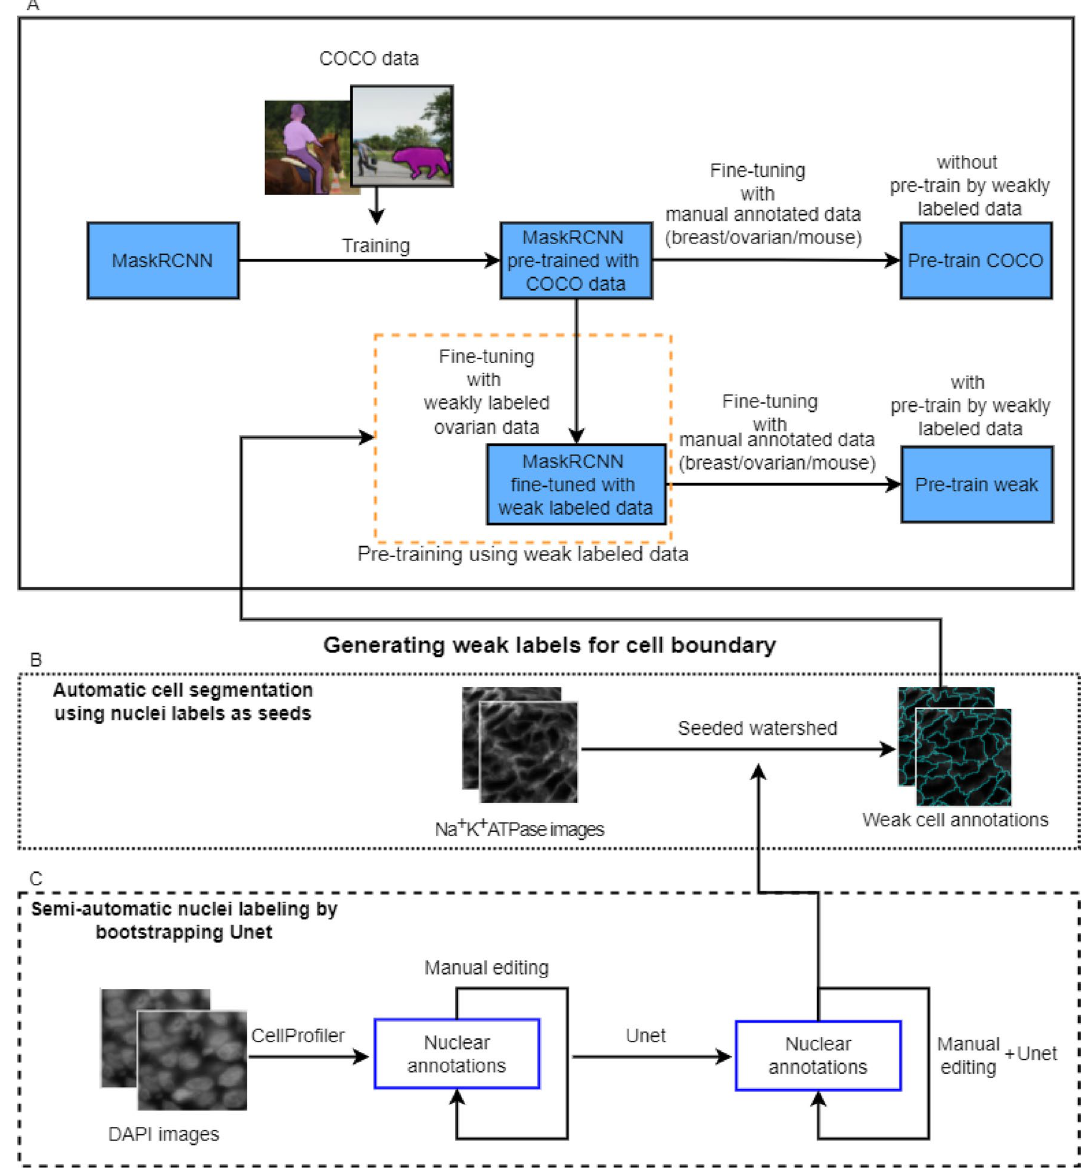
Figure 1. Workflow diagram for methodology: ( A ) (within black solid box) demonstrates the methods of training a Mask R-CNN model using domain adaptation with and without pre-training using weakly labeled ovarian data. The corresponding final models are referred to as pre-train weak and pre-train COCO respectively. The dotted and dashed boxes (i.e. B and C ) demonstrate the process of generating weak annotations for the cell boundaries: ( B ) describes using the Na + K + ATPase image to generate weak (i.e. rough estimation) annotations for cell boundaries using seeded watershed by using nuclear labels as seeds. ( C ) demonstrates the semi- automatic nuclear segmentation using bootstrapped U-net after CellProfiler labeling and manual editing of the nuclear annotations. This figure is created using diagrams.net (https:// www. diagr ams. switch between the DAPI channel, MEM channel, and the stacked color images (SCI) during the process. A polygon tool was used to contour each individual cell. Cells were excluded if they met any of the following conditions: (1) overlapping nuclei; (2) membrane crossing over the nuclei; (3) out of focus nuclei; (4) faintly stained nuclei. The manual annotation process took approximately 2.5 hours per ROI for each observer.